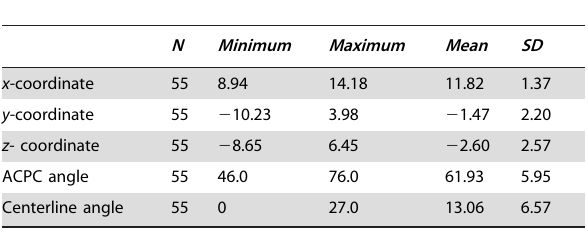
Table 5. Coordinate Analysis of STN Patient.